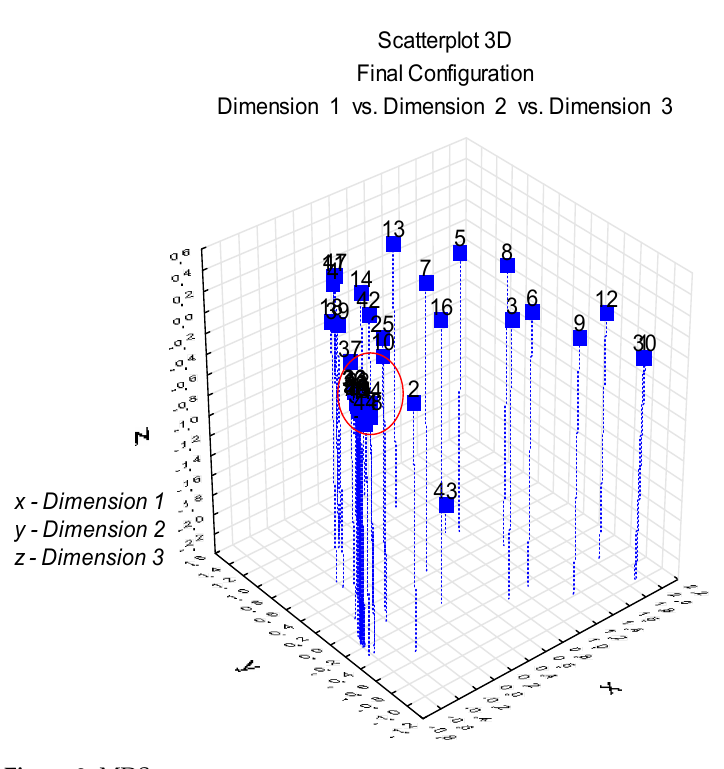
Figure 2. MDS map.